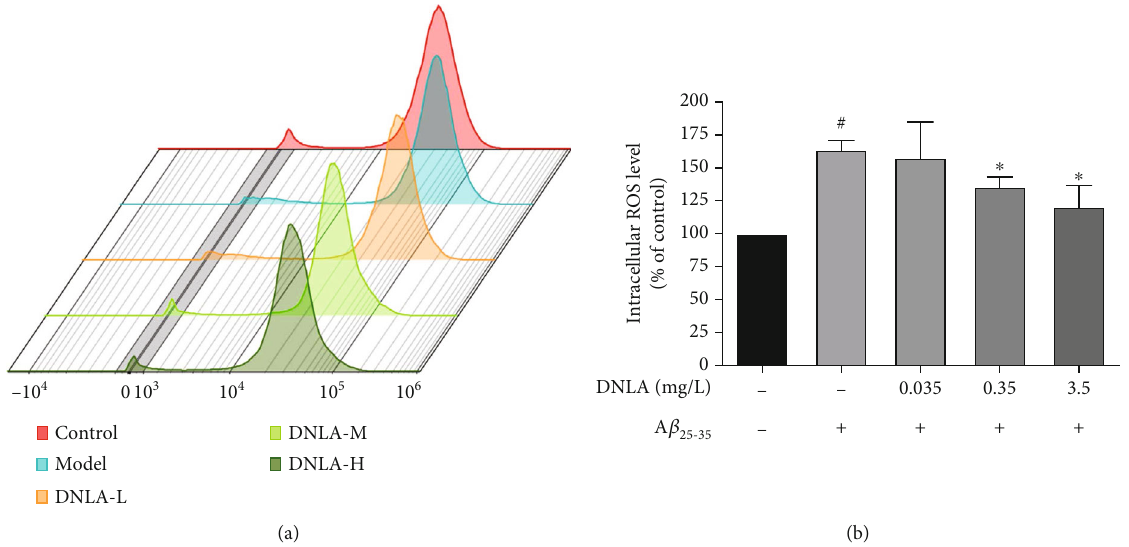
Figure 4: E ff ect of DNLA on the level of ROS in PC12 cell damage induced by A β detect intracellular ROS level in control, model, DNLA-L, DNLA-M, and DNLA-H groups, respectively; (f) The intracellular ROS level of the cells ( n = 3 , (cid:1) x ± s ). Note: # P < 0 : 05 vs. control; ∗ P < 0 : 05 vs. model.